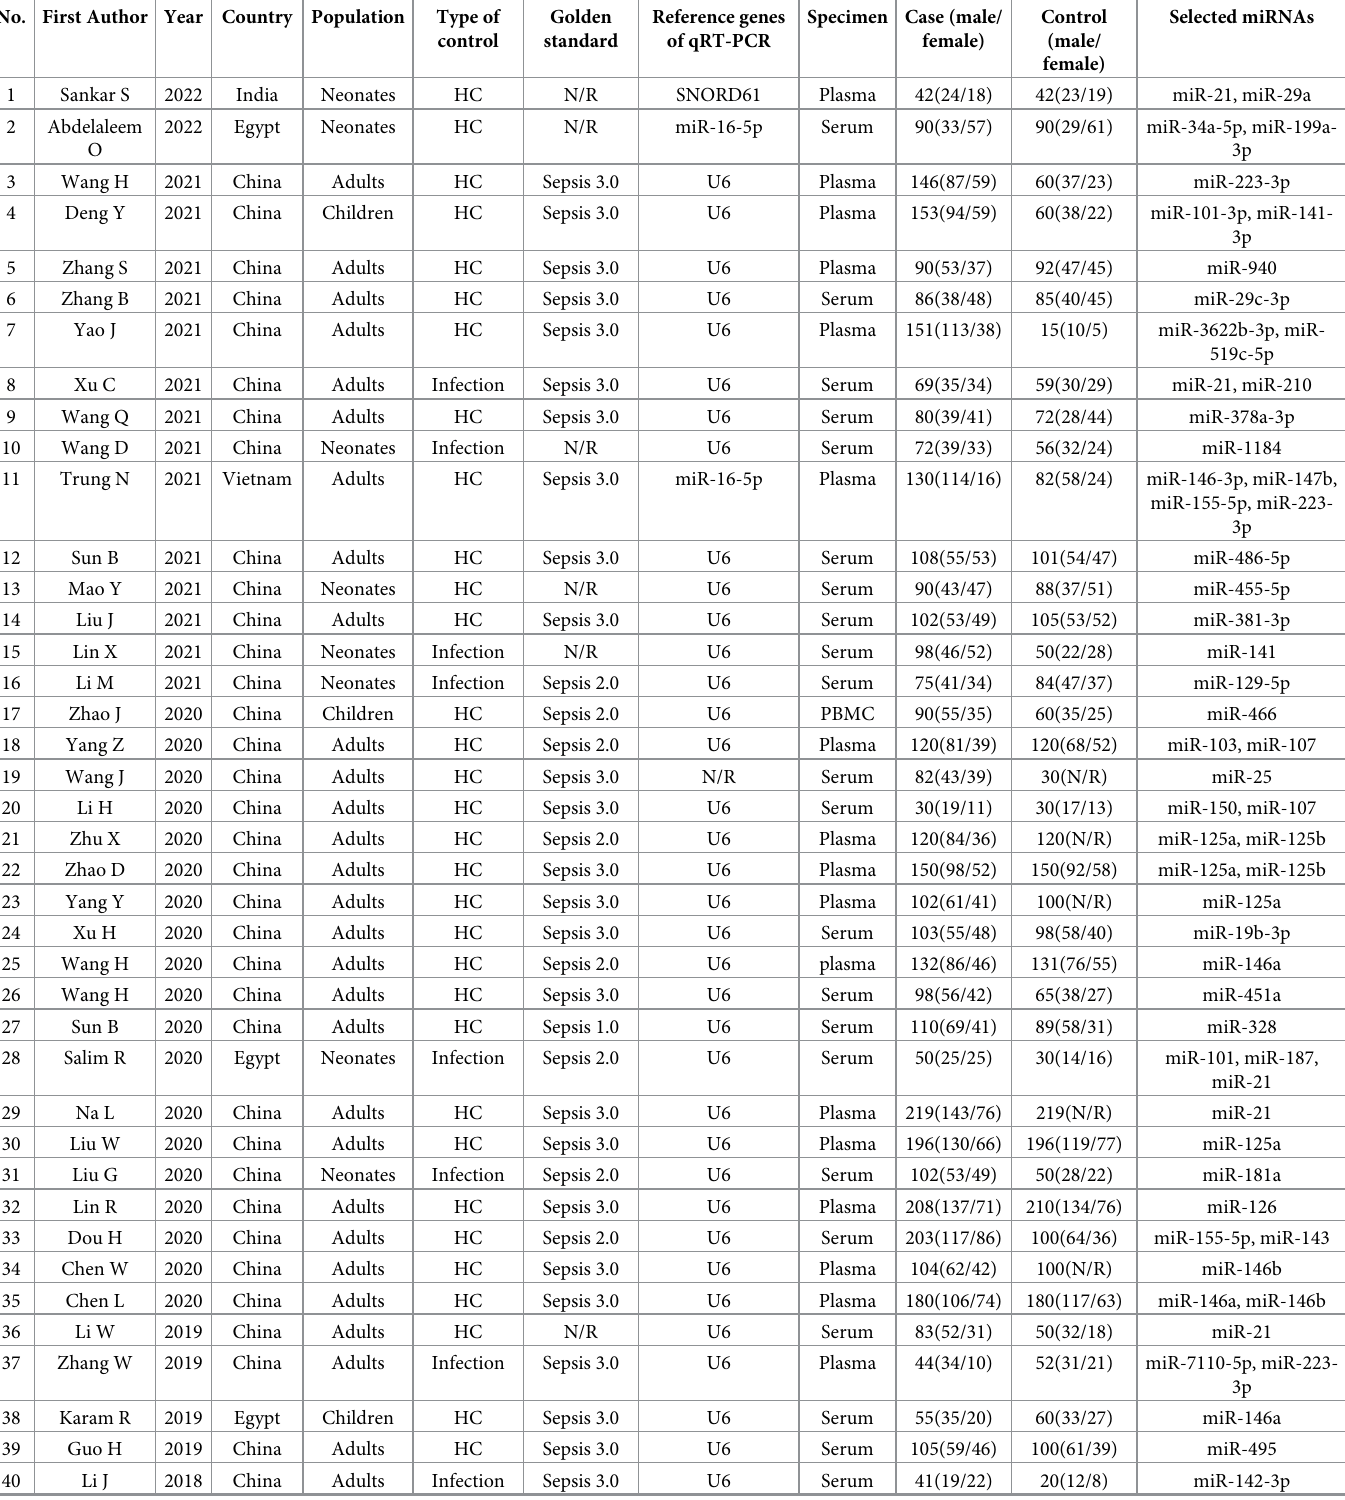
Table 1. Characteristics of studies in